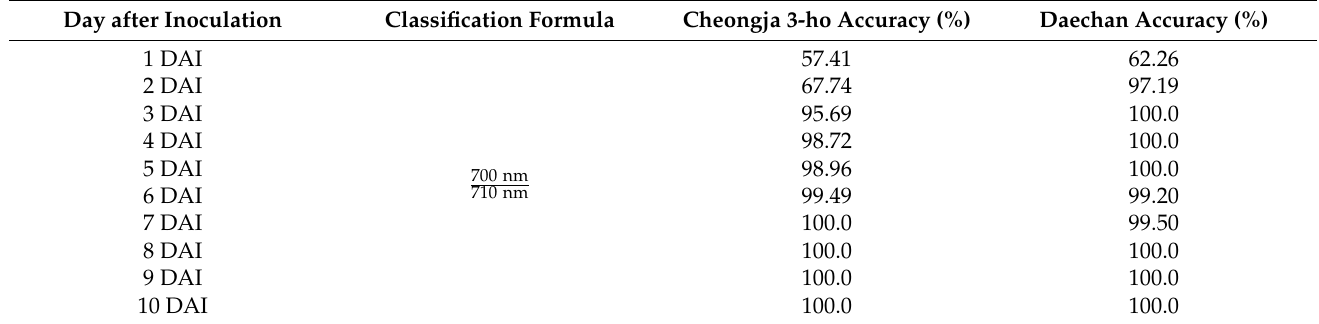
Table 1. Classification accuracy obtained via two-way analysis of variance analysis.